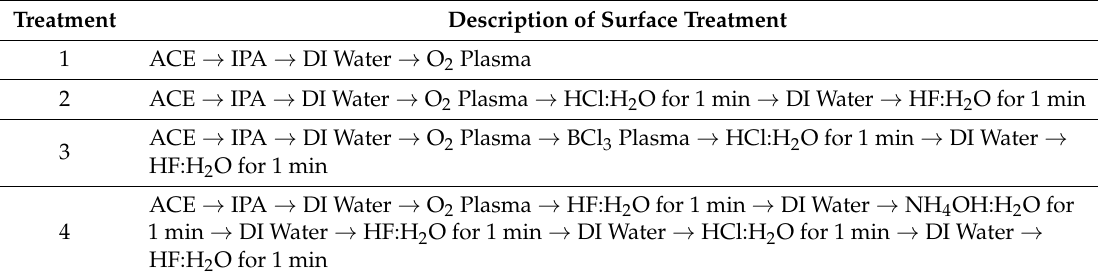
Table 1. The four chemical pretreatment